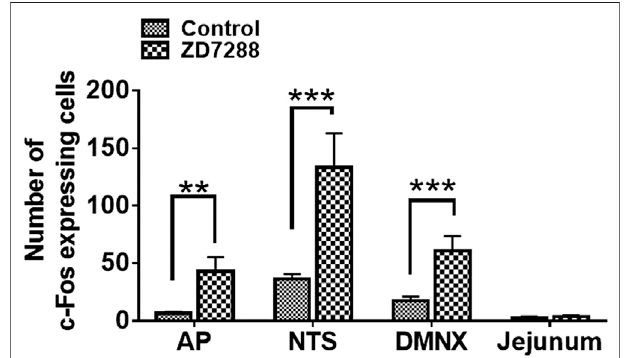
FIGURE5| Quanti fi eddataforZD7288-inducedc-Fosexpressioninthe least shrew brainstem dorsal vagal complex, containing the area postrema (AP), the nucleus tractus solitarius (NTS) and the dorsal motor nucleus of the vagus(DMNX),aswellastheentericnervoussystem(ENS)embeddedin the wall of jejunum. Values represent the mean number of c-Fos positive cells in each region of interest per section and are presented as mean ± SEM ( n (cid:2) 4 shrews per group). * p < 0.05, ** p < 0.01, *** p < 0.001 vs.Control(treated with vehicle of ZD7288), Unpaired t -test.